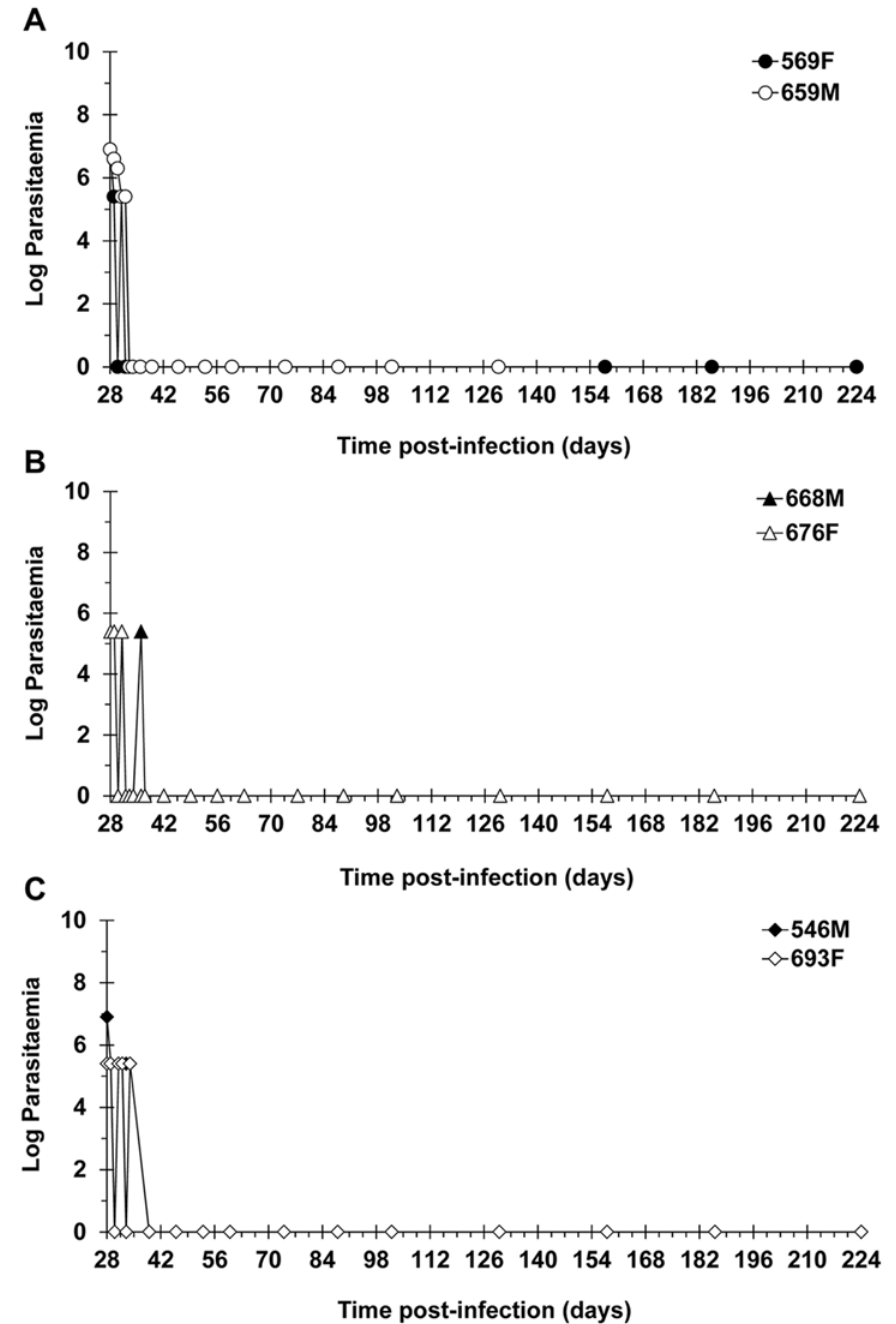
Fig 4. Resolution of parasitaemia in infected vervet monkeys treated with the active diamidine DB829. Monkeys were infected with T. b. rhodesiense KETRI 2537 and later confirmed to have progressed to second stage HAT, were administered with DB829 intramuscularly at ( A ) 5 mg/kg/day for 5 consecutive days (28 – 32 days post-infection), ( B ) 5 mg/kg/day for 5 alternate days (28, 30, 32, 34 and 36 days post-infection), or ( C ) 2.5 mg/kg/day for 5 consecutive days (28 – 32 days post-infection). F, female; M, male.